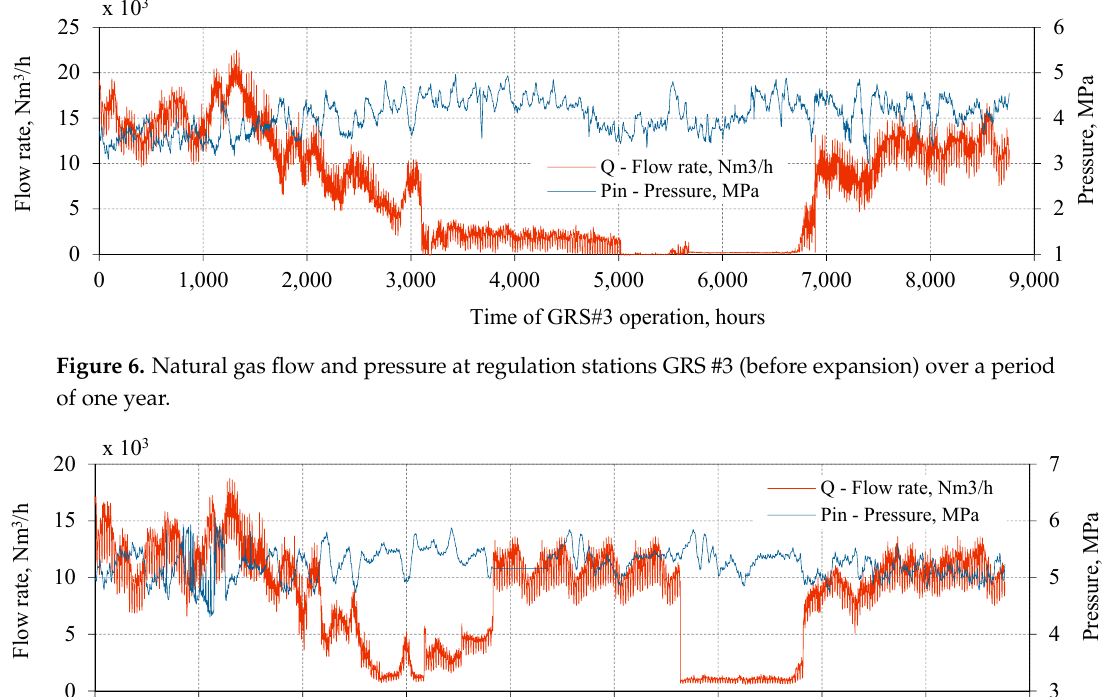
Figure 5. Natural gas flow and pressure at gas regulation stations (GRS) #2 (before expansion) over a period of one year.